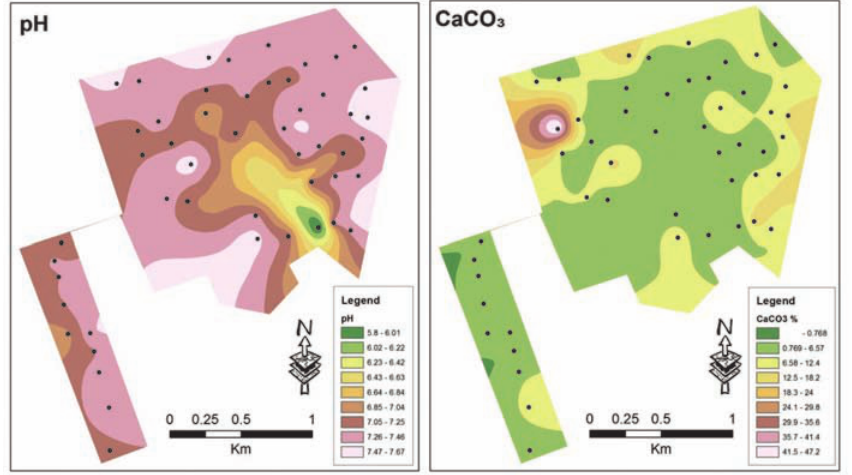
Figure 3. Spatial distribution of pH and CaCO